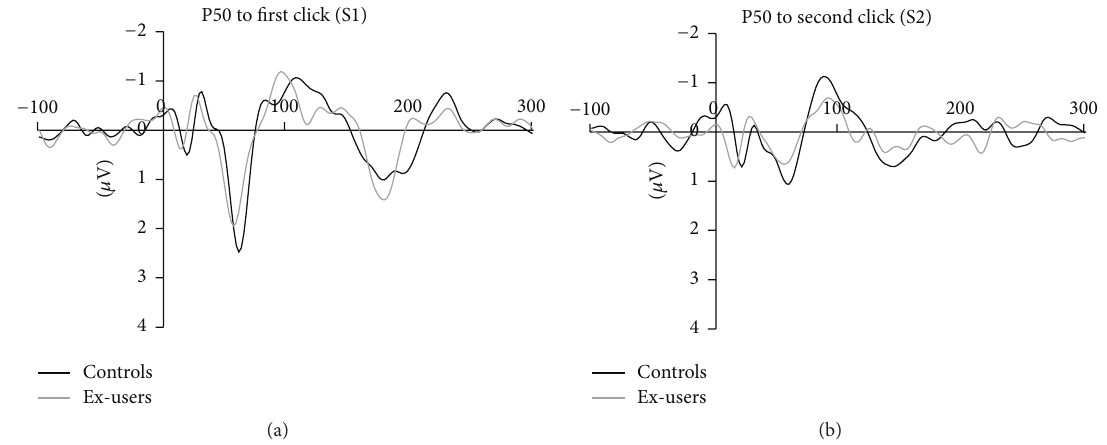
Figure 3: ERP waveforms to the first (S1; (a)) and second (S2; (b)) click at Cz for ex-cannabis users (grey) and nonuser controls (black). Amplitude is shown in 𝜇 V on the 𝑦 -axis and time in milliseconds along the 𝑥 -axis.